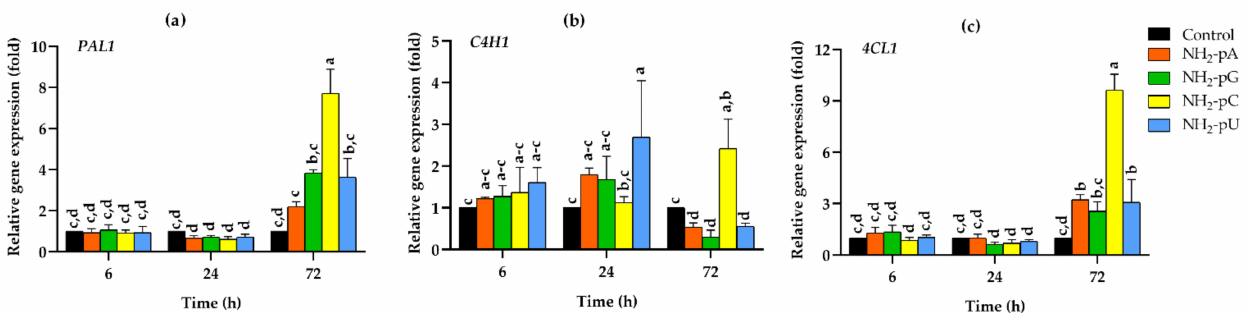
Figure 3. Expression of general phenylpropanoid pathway genes in cells of Vitis vinifera cv. Monastrell treated with 5 µ M nucleoside 5 (cid:48) -phosphoramidates. ( a ) PAL1 , phenylalanine ammonia-lyase; ( b ) C4H1 , cinnamate-4-hydroxylase; ( c ) 4CL1, 4-coumarate:CoA ligase. Total RNA was reverse-transcribed into cDNA and used as a template for real-time quantification PCR reaction as described in the Section 4. Specific primers were designed for PAL1 , C4H1 , 4CL1 , and EF α 1 (elongation